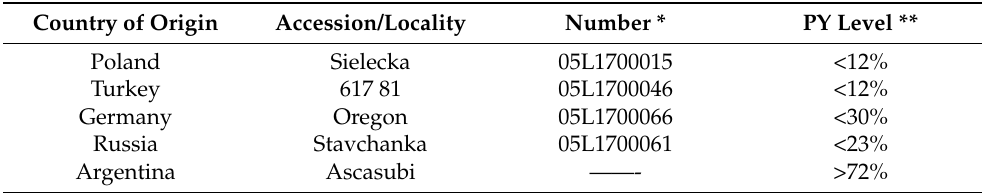
Table 1. Country, name of hairy vetch accessions included in the study and average level of seeds’ physical dormancy